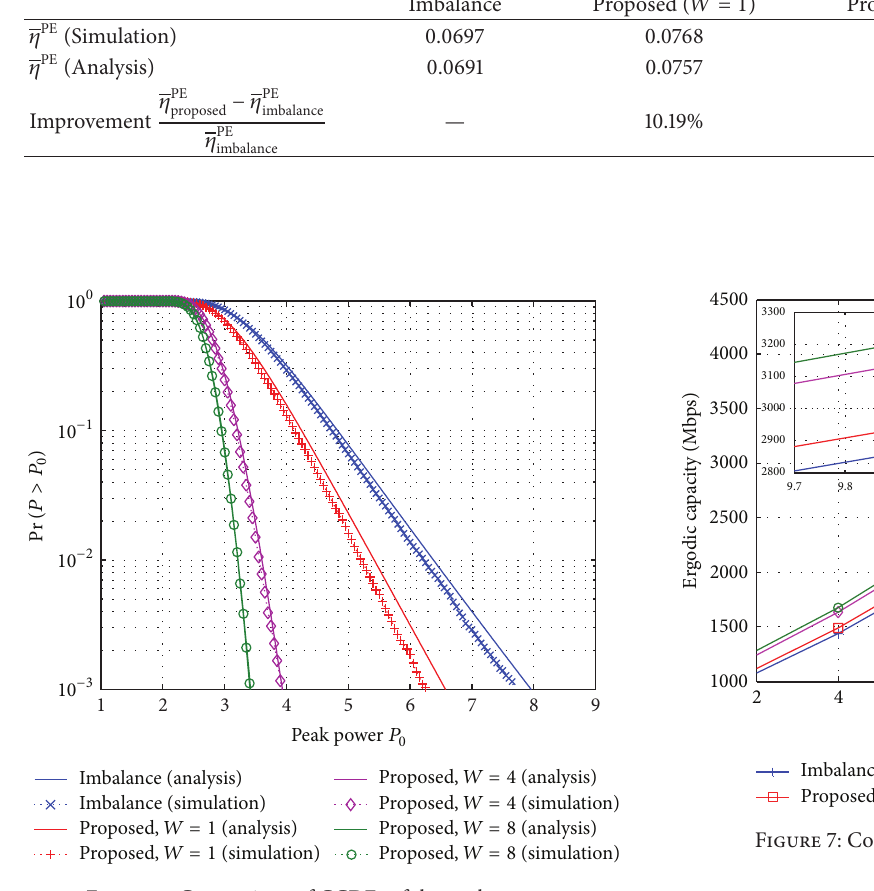
Figure 5: Comparison of CCDFs of the peak powers.